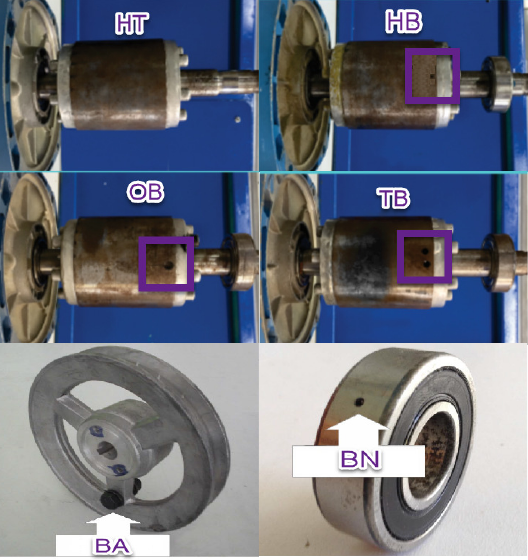
Figure 3. Faults setup . Healthy condition (HT), half broken bar (HB), one broken bar (OB), two broken bar (TB), unbalanced pulley (BA), and bearing fault (BN). Drilled holes in broken bars are shown in purple